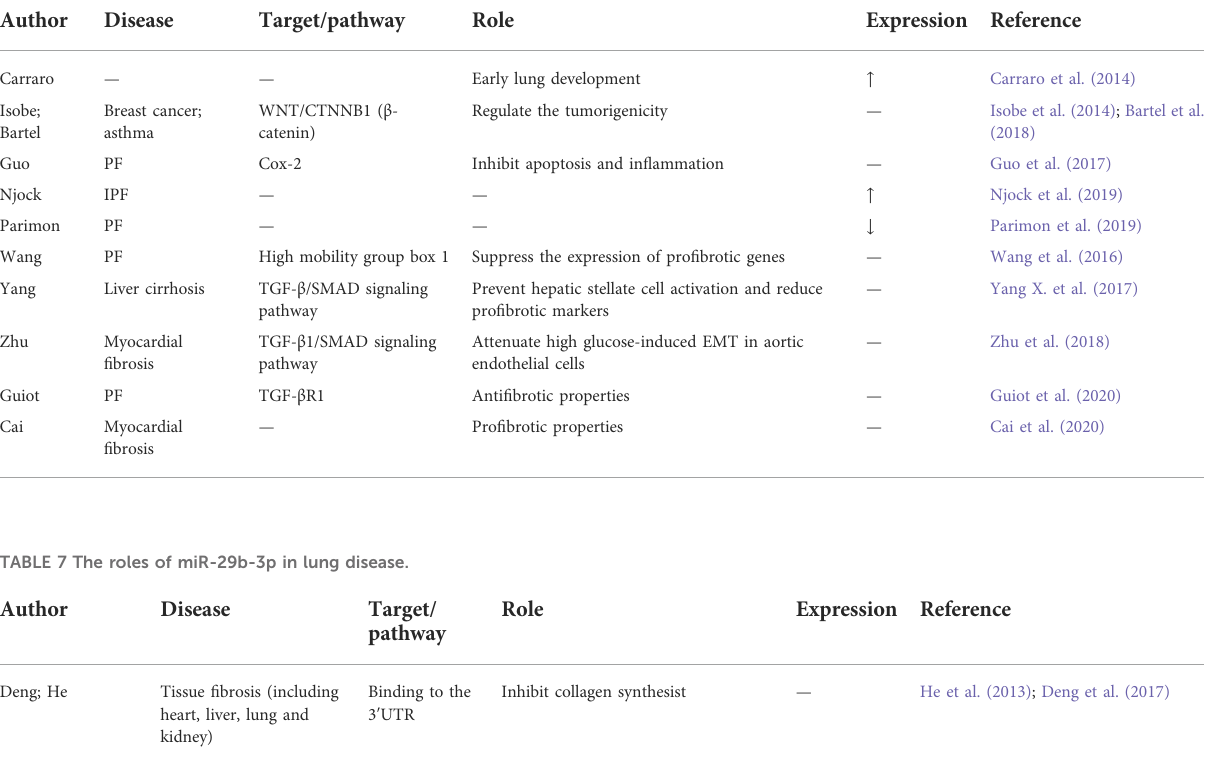
TABLE 6 The roles of miR-142-3p in lung disease.